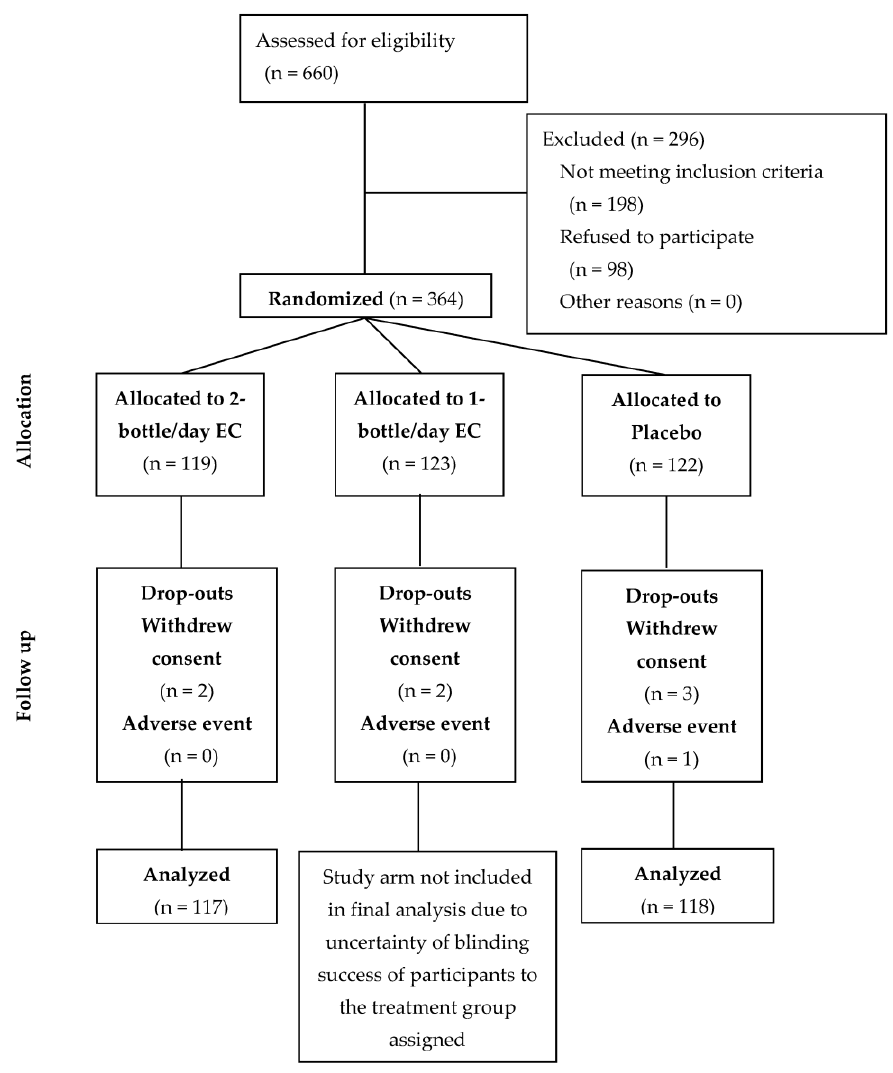
Figure 1. Participant flow diagram in the study based on the CONSORT flow diagram.